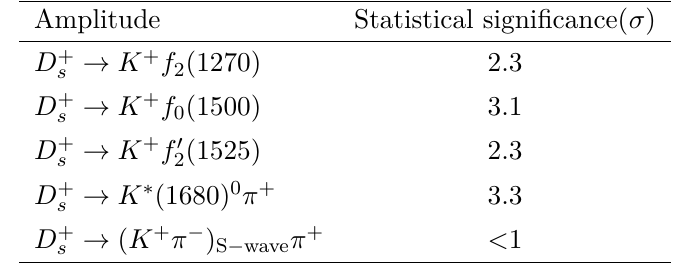
→ K + f 0 (500) , IV D + s